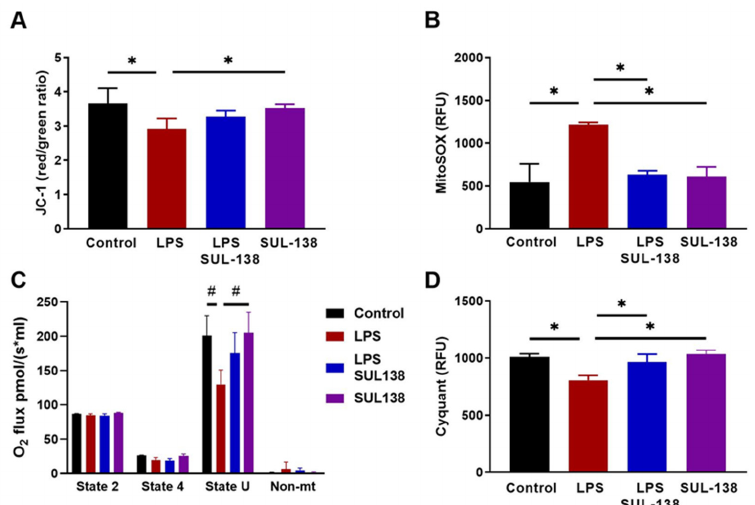
Figure 1. SUL-138 prevents LPS-induced mitochondrial dysfunction and cell death in HUVECs. HUVECs were incubated without and with SUL-138 (10 µM), followed, after 10 min, by incubation with LPS (100 µg/mL). ( A ) LPS for 24 h reduced mitochondrial membrane potential, which was precluded in the presence of SUL-138, as measured by JC-1 fluorescence (n = 16). ( B ) LPS for 24 h increased mitochondrial oxidative stress, which was inhibited by SUL-138, measured by MitoSOX (n = 16). ( C ) LPS for 24 h reduced mitochondrial oxygen consumption in the uncoupled state (State U; CCCP 5 µM), but not in the presence of SUL-138 (n = 4). State 4 was measured in the presence of oligomycin (1 µg/mL) and non-mt in the presence of AMA (5 µM). ( D ) LPS for 48 h reduced cell survival, which was precluded by SUL-138, as measured by Cyquant. (n = 16). Data are represented as mean ± SEM, One-way ANOVA, * p < 0.05 or Two-way ANOVA, # p < 0.05. AMA, Antimycin A; CCCP, carbonyl cyanide m-chlorophenylhydrazone; CLP, cecal ligation and puncture; LPS, lipopolysaccharide; non-mt, non-mitochondrial.